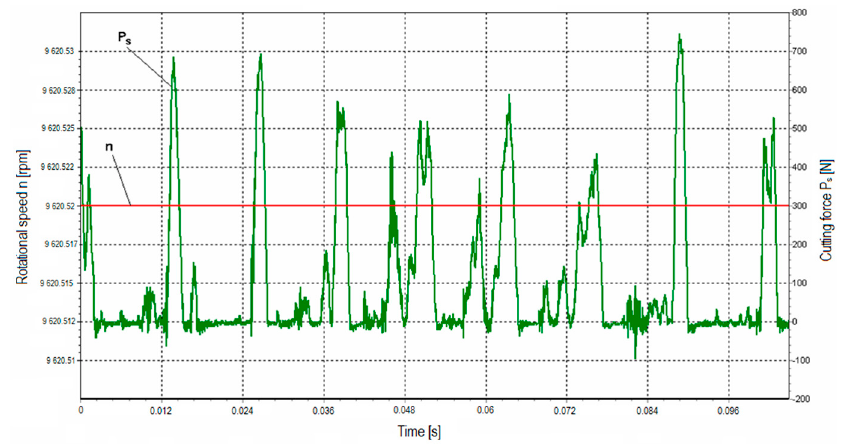
Figure 6. Cutting force variability at a feed force of 81 N.